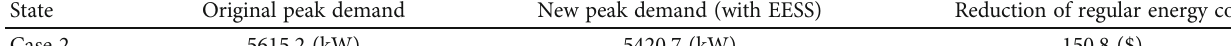
Table 5: Case 2 summary.